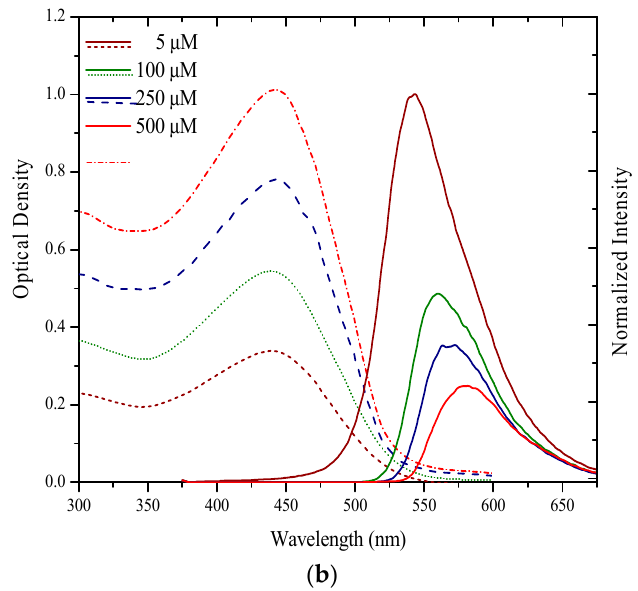
Figure 2. ( a ) Absorption and fluorescence spectra of MEH–PPV; ( b ) Absorption and fluorescence spectra of BMP. (In the above figures, discontinuous line represents absorption and continuous line represents fluorescence)